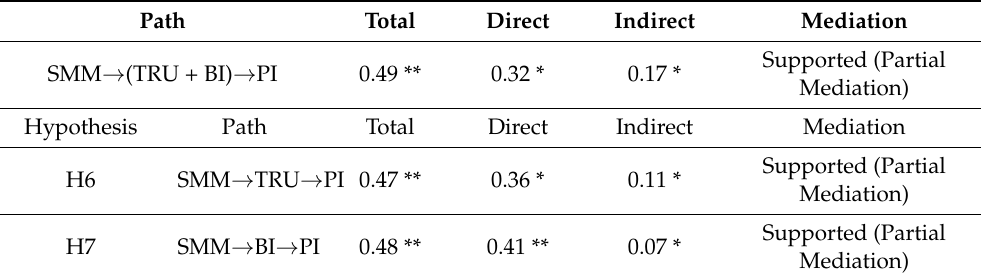
Table 6. Summary of mediation analysis results.